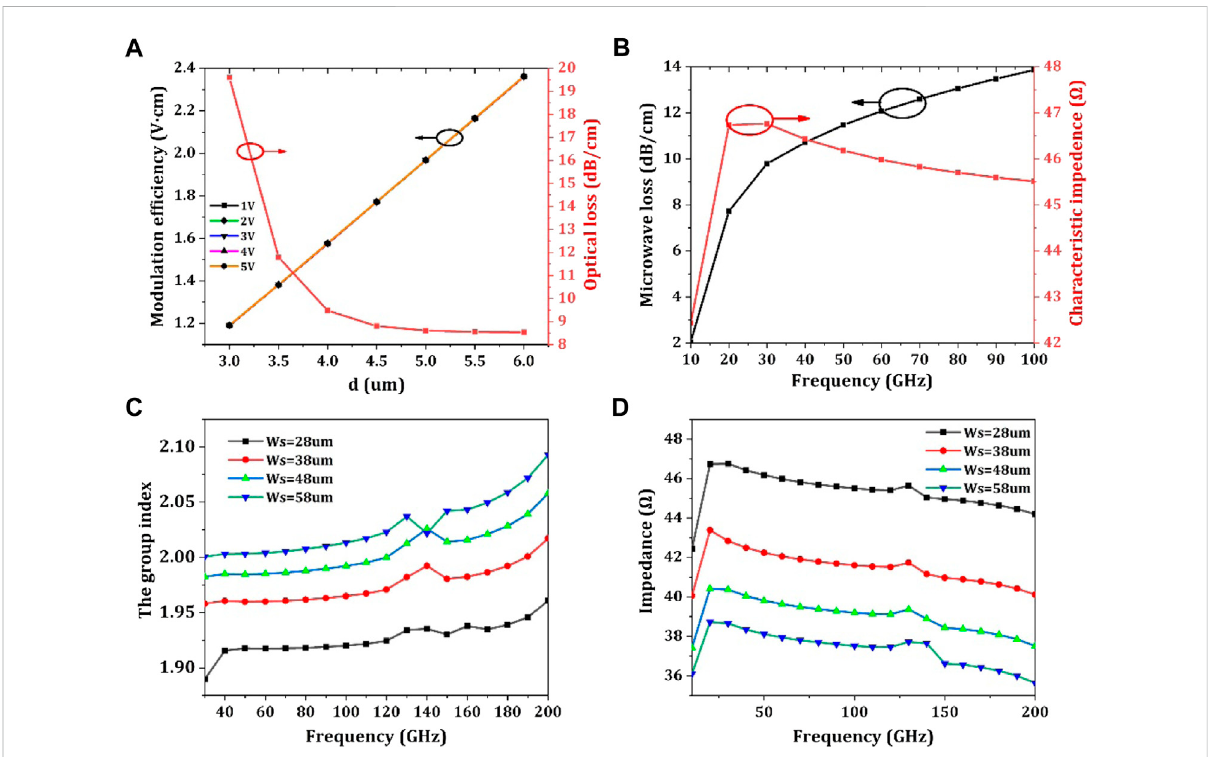
FIGURE 6 The simulation results of phase shifter (A) Modulation ef fi ciency and optical loss as a function of voltage and electrode spacing d (B) The microwavelossandimpedanceasafunctionoffrequencyofthephaseshifter (C) Themicrowavegroupindexunderdifferentsignalelectrodewidths as a function of frequency (D) Impedance under different signal electrode widths as a function of frequency.